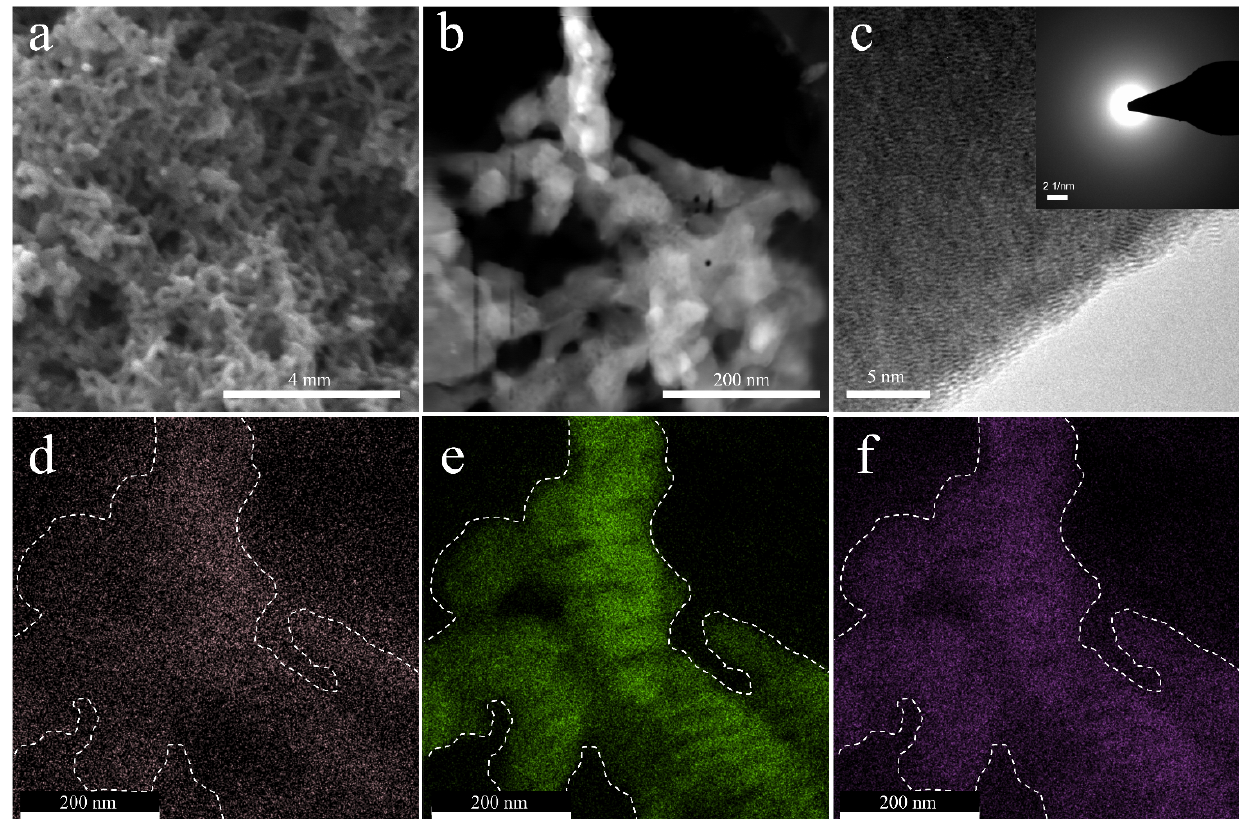
Figure 1. ( a ) SEM, ( b ) TEM, and ( c ) high ‐ resolution TEM images of PANI film. The inset of ( c ) shows the corresponding SAED image. ( d – f ) Corresponding EDS mapping of the nitrogen (N), oxygen (O), and sulfur (S) in PANI film.